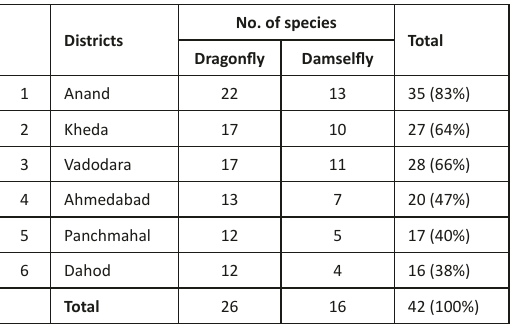
Table 2. Species richness of dragonflies and damselflies in central